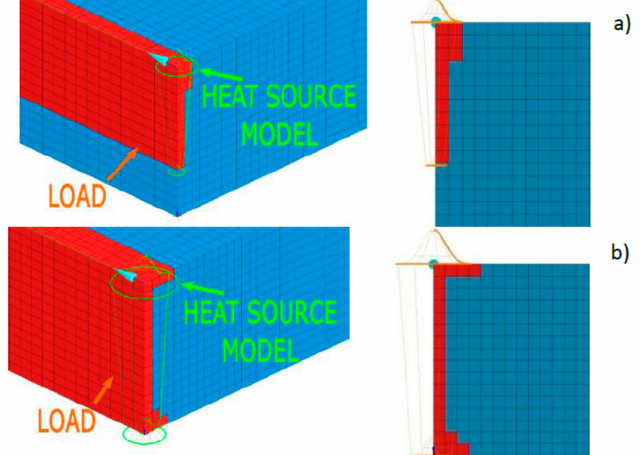
Figure 9. Examples defining the loaded areas of the model (network) and location of the heat source model in the case of laser welding with the mesh technique with ( a ) incomplete and ( b ) full